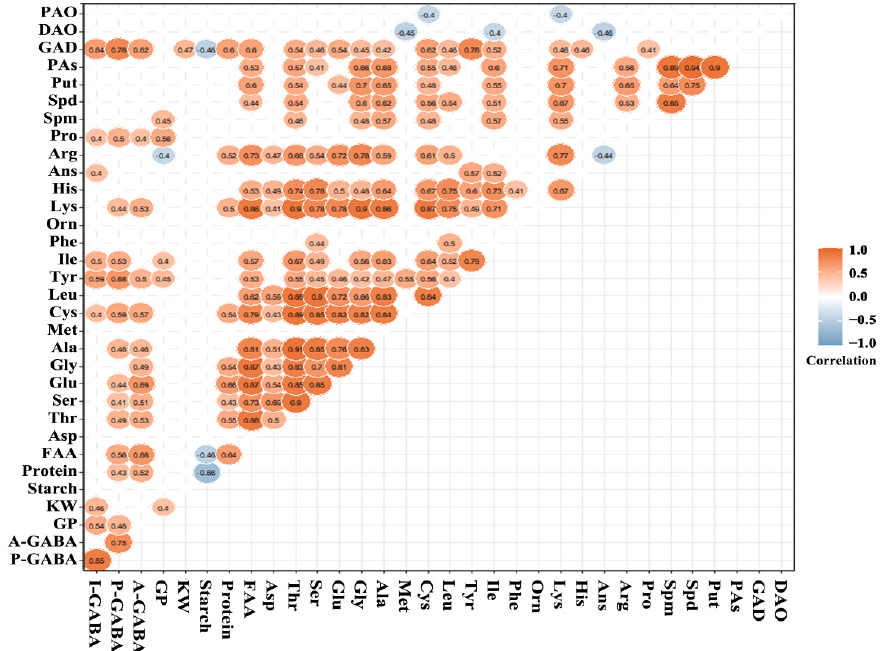
Figure 6. Correlations in physical, chemical and biochemical characteristics. The non-significant correlations were not displayed. I-GABA, the initial GABA content; P-GABA, the GABA content after HRH processing; A-GABA, the GABA accumulation content after HRH processing.